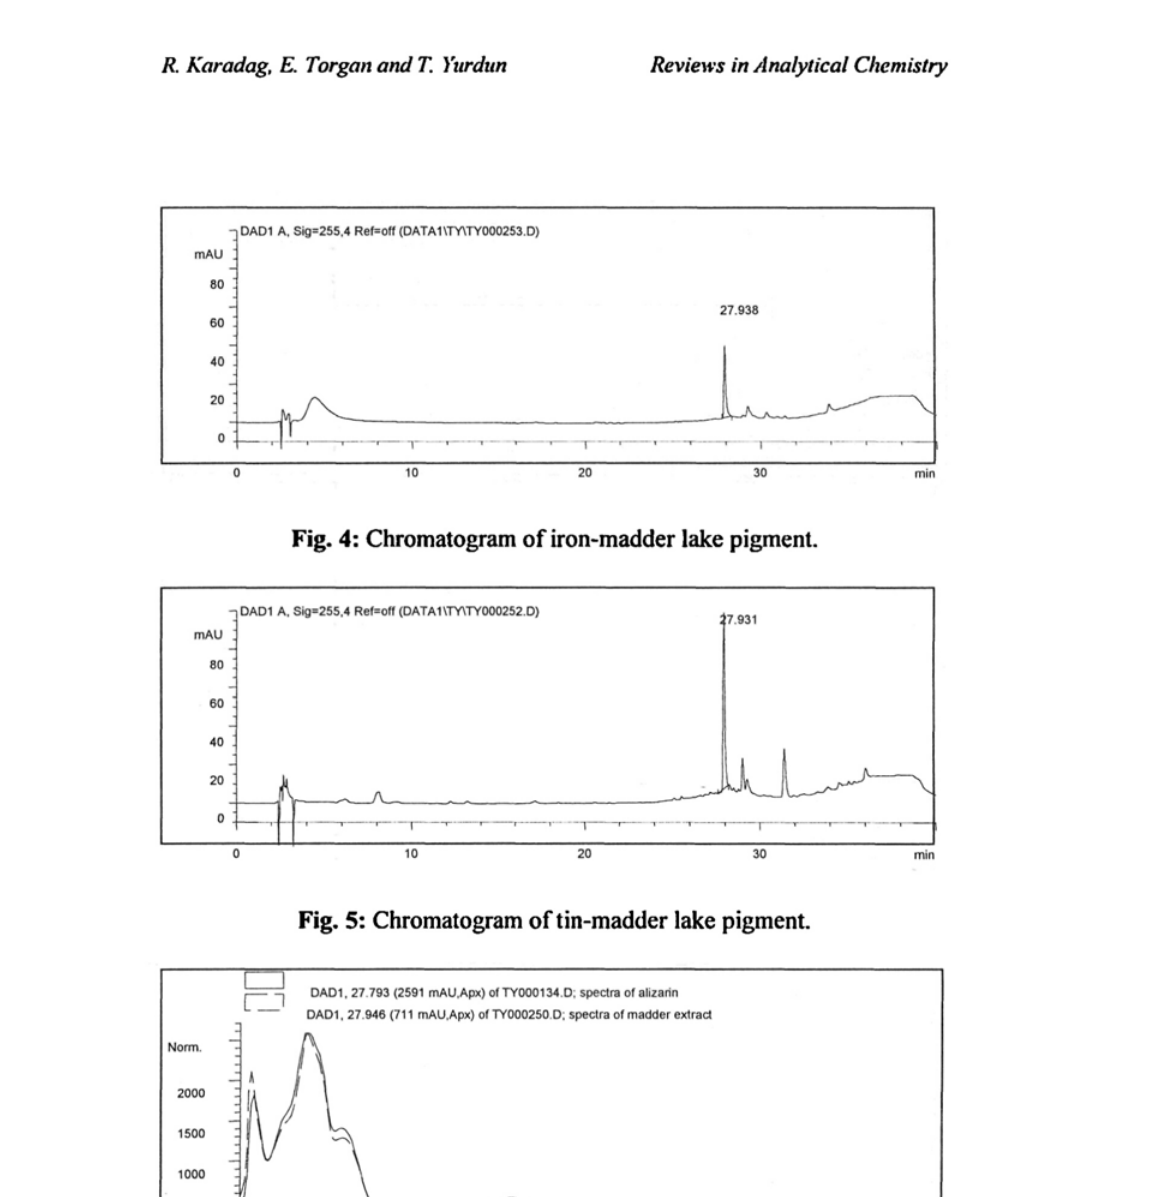
Fig. 6: Spectra of madder